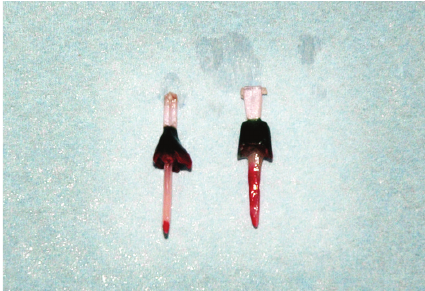
Figure 6: Cementation of a crown under static